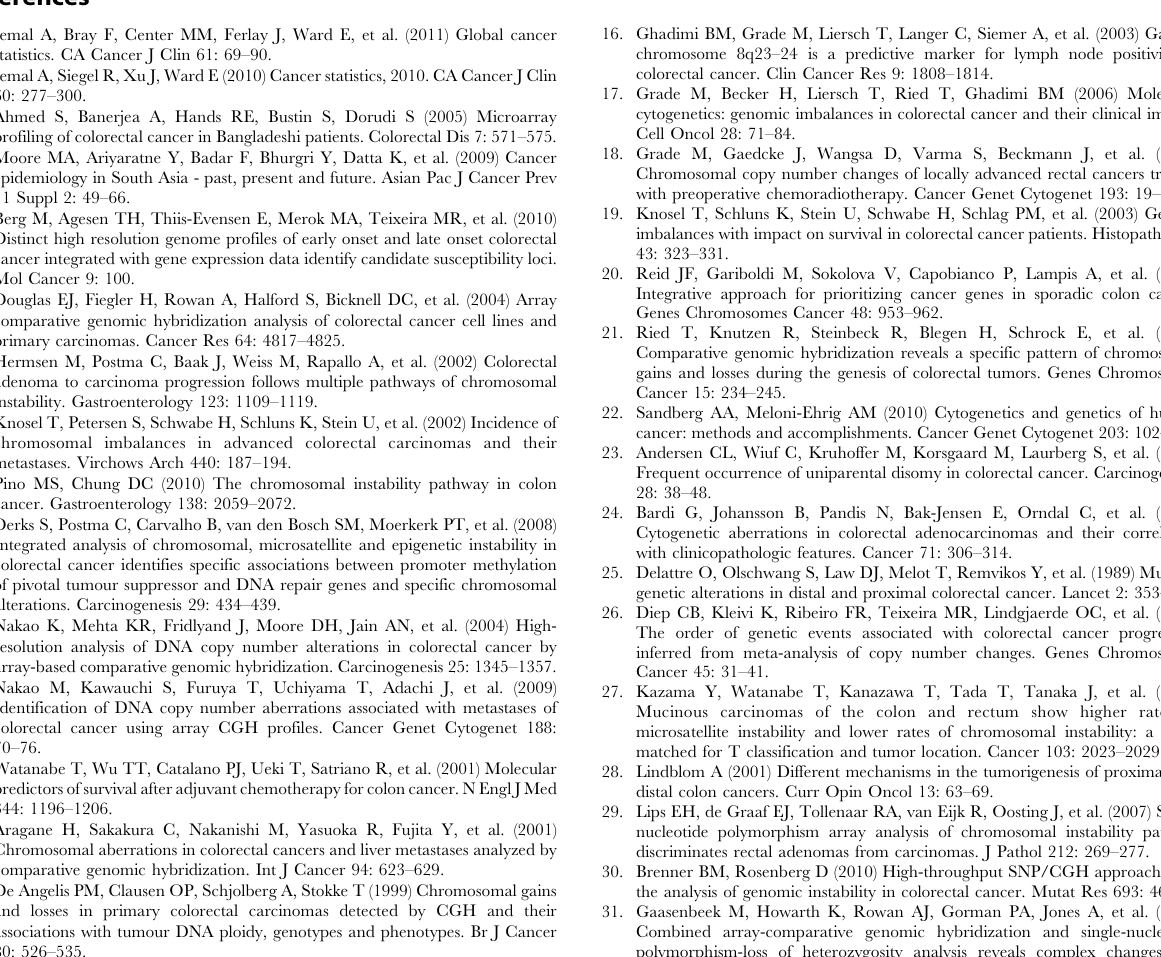
Figure S1 Normalized melt curves and corresponding differen- tial curves for BAT25, BAT26 and CAT 25 amplicons. Each line represents one sample. MSS samples are shown in red. MSI samples are shown in green. (TIF) Table S1 Association of CN changes with MSI status. (CSV) Table S2 Association of CN changes with histological diagnosis. (CSV) Table S3 Association of CN changes with tumor location. (CSV) Table S4 Association of CN changes with tumor grade. (CSV) Table S5 Association of CN changes with tumor stage. (CSV)